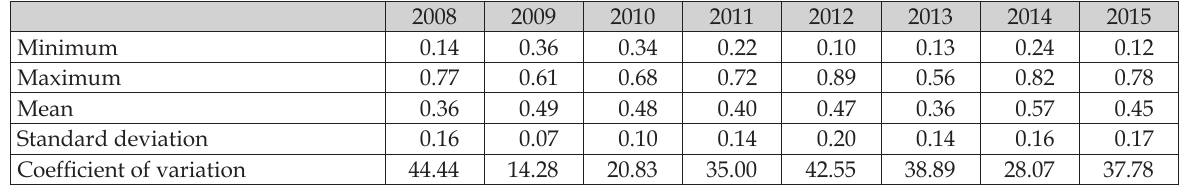
Fig. 2. Classification of rural regions based on SSRR index for Austria in 2008 and 2015. Source: own calculations using data from Eurostat. Table 5. Descriptive statistics of SSRR index for Portugal, 2008–2015.